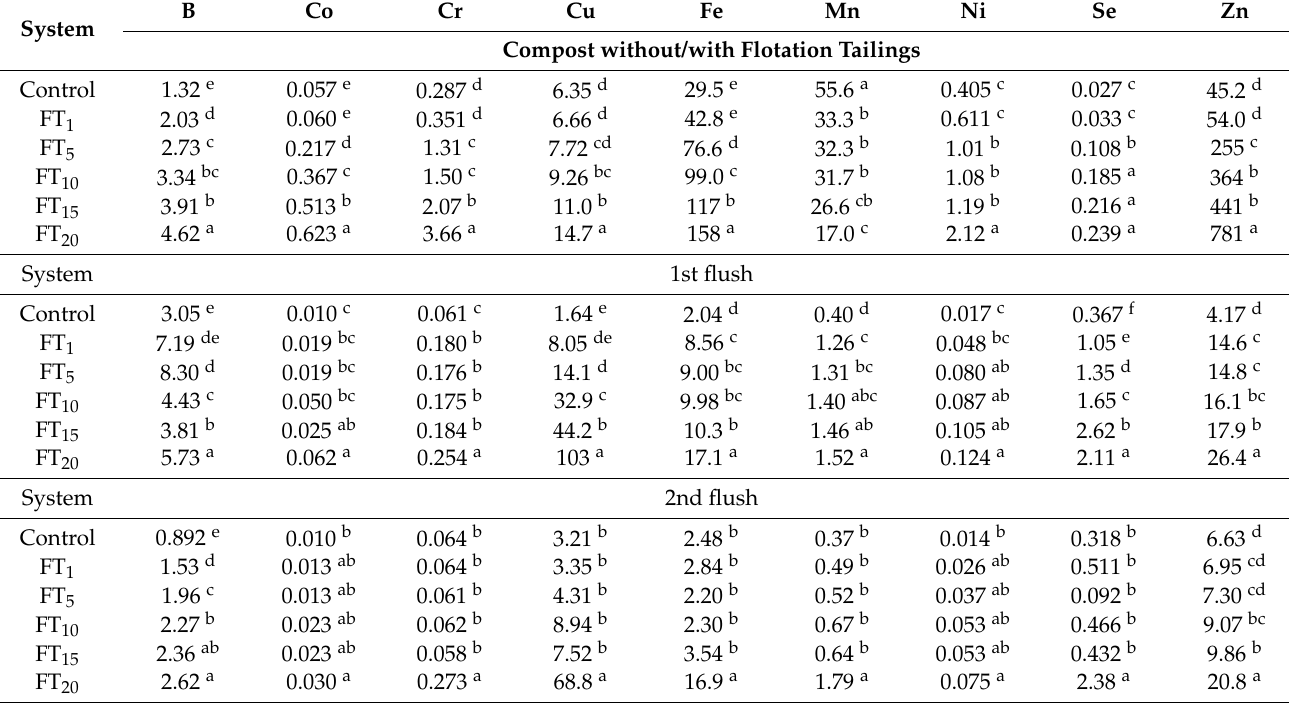
Table 3. Content of essential trace elements [mg kg − 1 dry weight] in compost with flotation tailings before the experiment and fruit bodies from particular